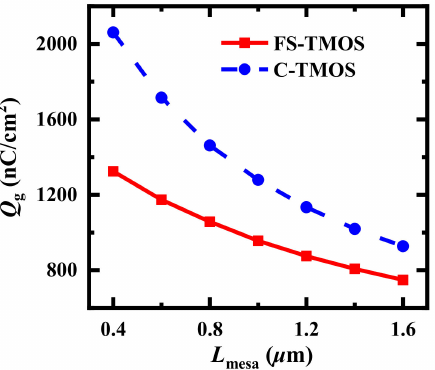
Figure 4. Q g of FS- and C-TMOS dependent on L mesa . The L sps is 1 µ m. Furthermore, the distance between the two adjacent SPS L sps influences the third quad- rant performance as shown in Figure 5. With wider L sps , the reverse conduction capability (the drain-source current, I ds ) enhances gradually. On the other hand, the turn on voltage ( V on ) is degraded evidently when L sps is lower than 0.8 µ m. Considering state-of-the-art process technologies for SiC power devices and fundamental capability, the L mesa and L sps are optimized to be fixed 1 µ m and 1 µ m, respectively, in the following discussions.